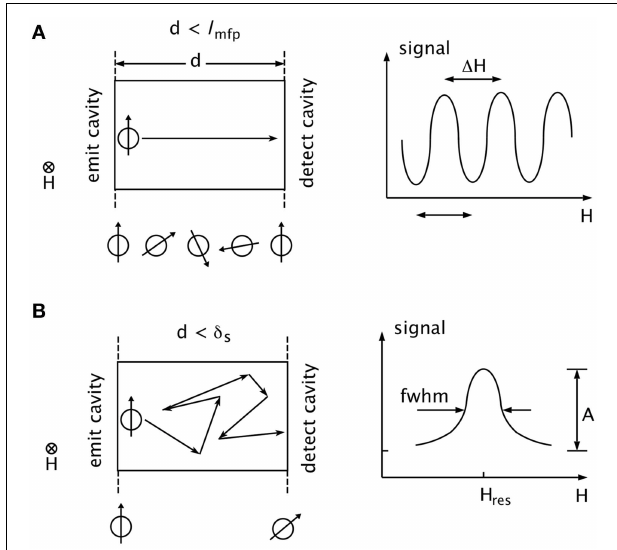
FIGURE 2 | Schematic description of transmission electron spin resonance (TESR) in different transport regimes. Left panels: Cross section of metal foil samples having thickness d , with transmit cavity on left and detect cavity on right, and depiction of carrier transport. Right panels: qualitative sketch of detected resonance signals. (A) Carrier transport is ballistic. (B) Carrier transport is diffusive.